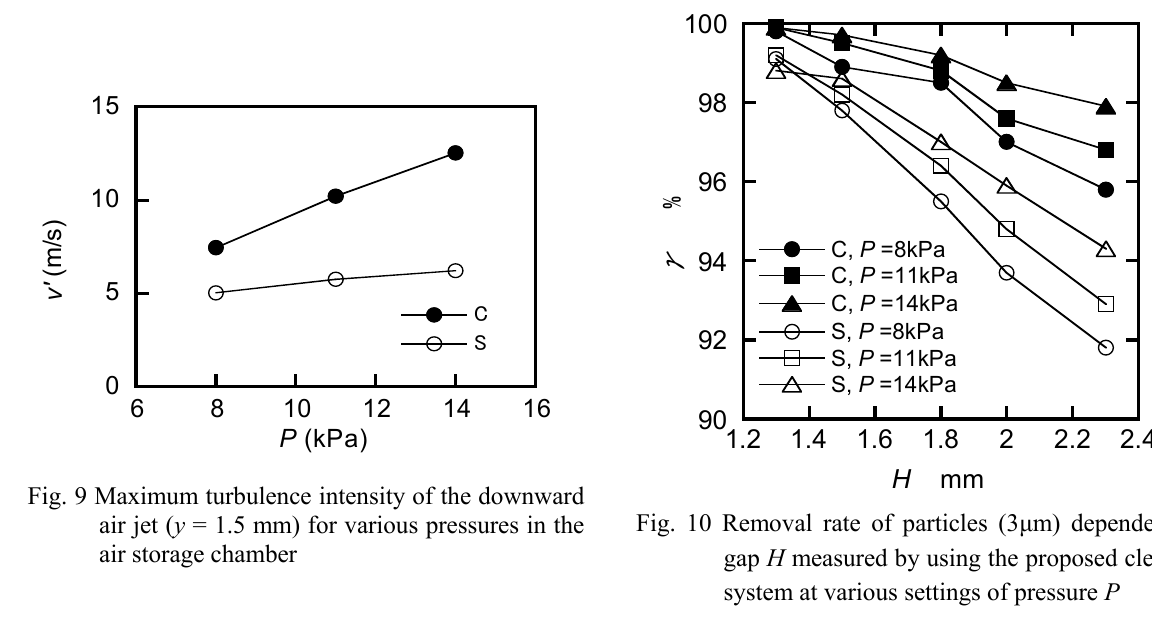
Fig. 8 Distribution of turbulence intensity of the downward velocity of the air jet ( y = 1.5 mm) in x direction for both types of